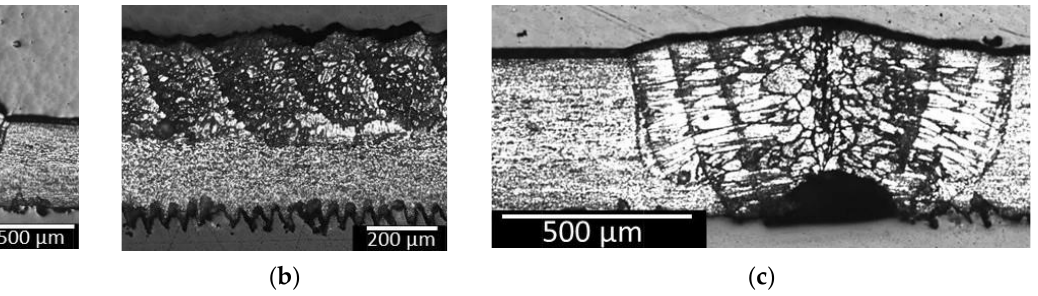
Figure 14. Cross-section of the weld area in transversal direction ( a ); and longitudinal direction ( b ); at the modulated power of 280 W; cross-section of the weld area in transversal direction at the modulated power of 310 W ( c ).